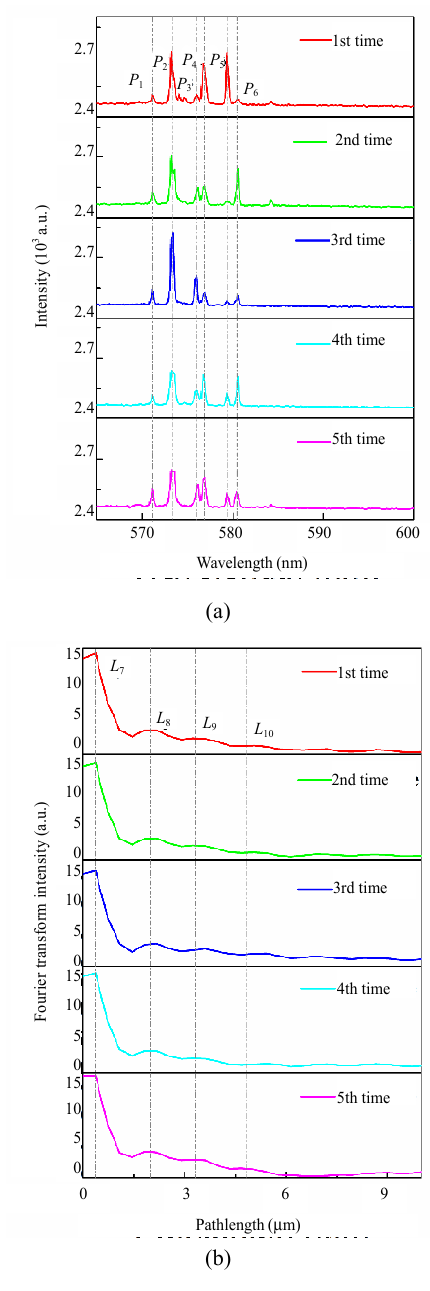
Fig. 8 Random lasing emission and Fourier transform: (a) random laser spectra of the vesicles solution at different pump times with the same pump energy of ~500 µJ and (b) Fourier transform corresponding to the emission